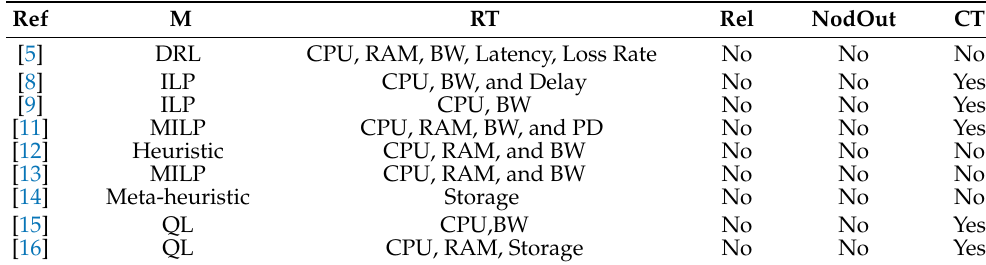
Table 1. Summary of related